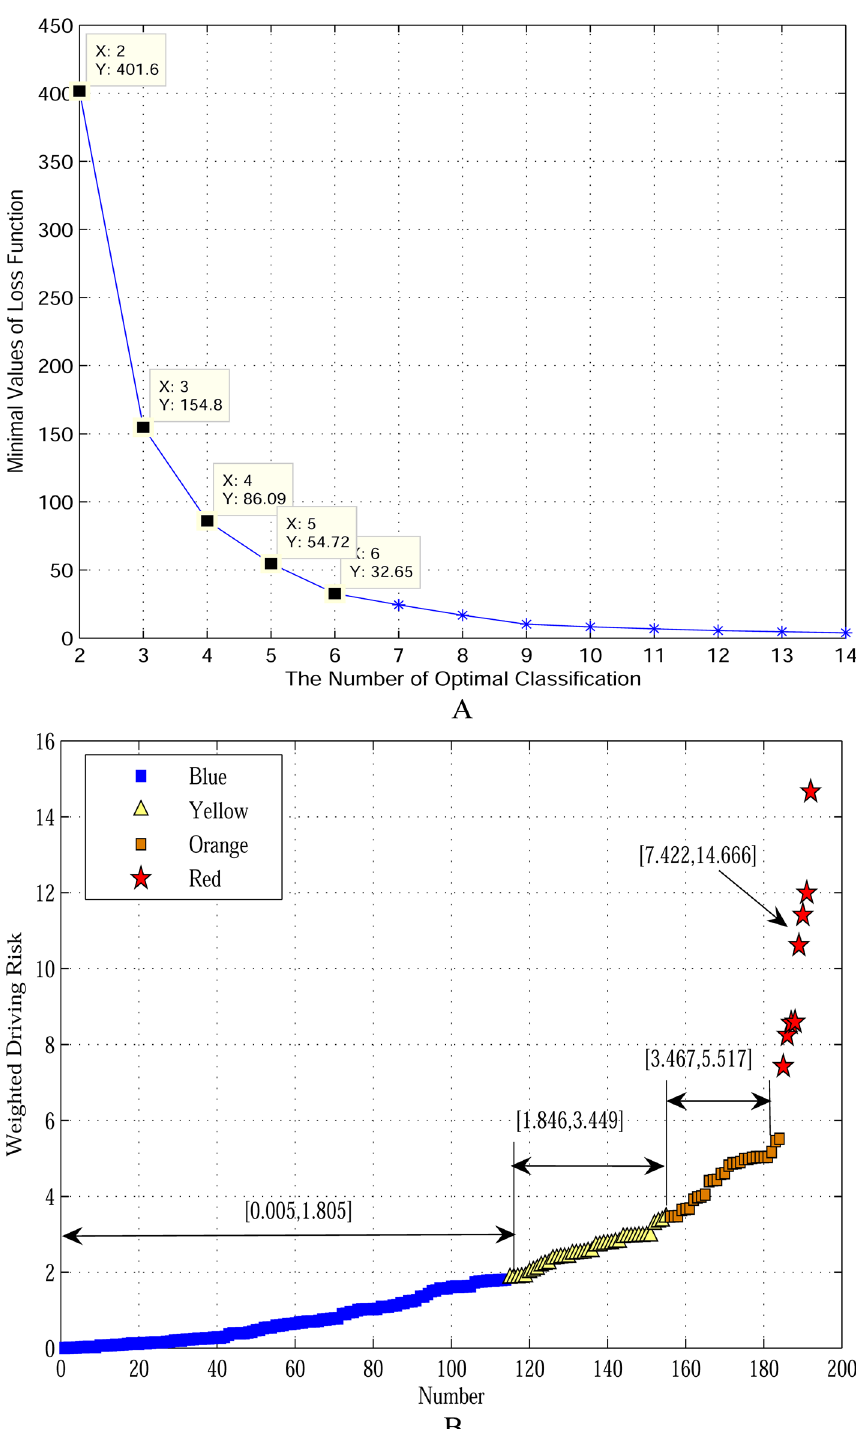
Fig 3. Results of the rank order cluster analysis through MATLAB programming. Panel A shows minimal loss functions vary with number of classifications. Panel B shows distribution ranges of four levels of weighted driving risk (k =